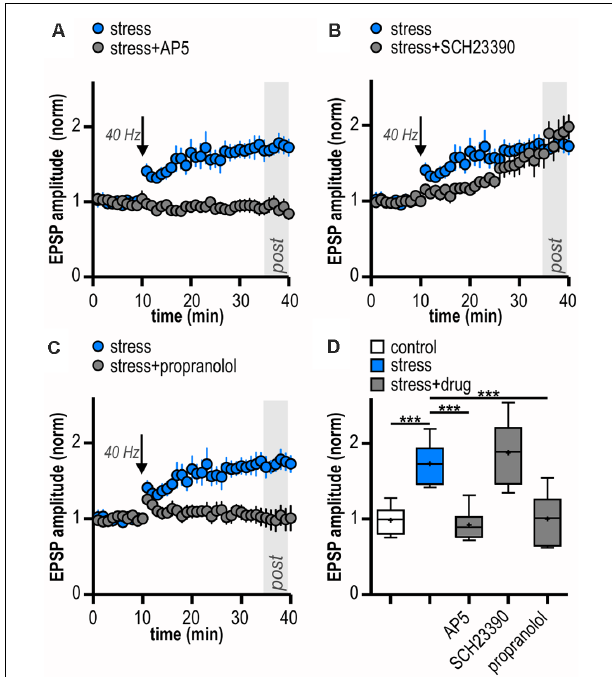
FIGURE 4 | LTP in stressed rats is induced by activation of N -methyl-D-aspartate receptors (NMDAR) and β -adrenergic receptors ( β -AR). (A) Bath-application of the NMDAR antagonist AP5 blocks LTP in stressed rats. (B) The D1/D5R antagonist SCH23390 does not block the induction of LTP in stressed rats. (C) The β -AR antagonist propranolol prevents the induction of LTP in stressed rats. (D) Quantification of mean normalized EPSP amplitudes following attenuated HFS (10 pulses at 40 Hz) for the different experimental groups (one-way ANOVA: F (4,27) = 15.84, *** p < 0.001, followed by post hoc Dunnett’s test, *** p < 0.001). Stress/control data taken from Figures 2C,D is replotted in (A–D) for comparison.